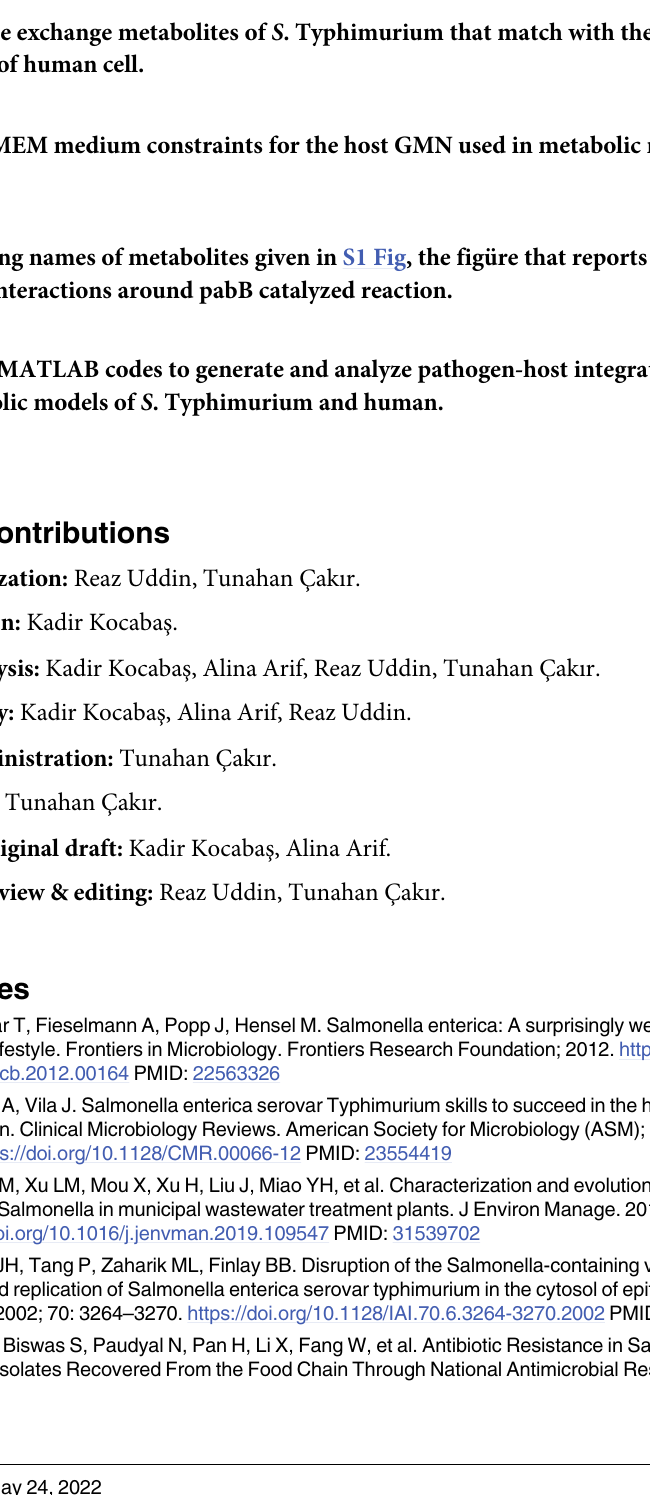
S5 Table. Binding energy, Zinc IDs, 1D and 2D structure of each of top 10 compounds. S6 Table. Metabolites that can be consumed by S . Typhimurium inside host cytoplasm in pathogen-host GMN model. S7 Table. The exchange metabolites of S . Typhimurium that match with the cytoplasmic metabolites of human cell. S8 Table. DMEM medium constraints for the host GMN used in metabolic model simula- tions. S9 Table. Long names of metabolites given in S1 Fig, the figu¨re that reports metabolite- metabolite interactions around pabB catalyzed